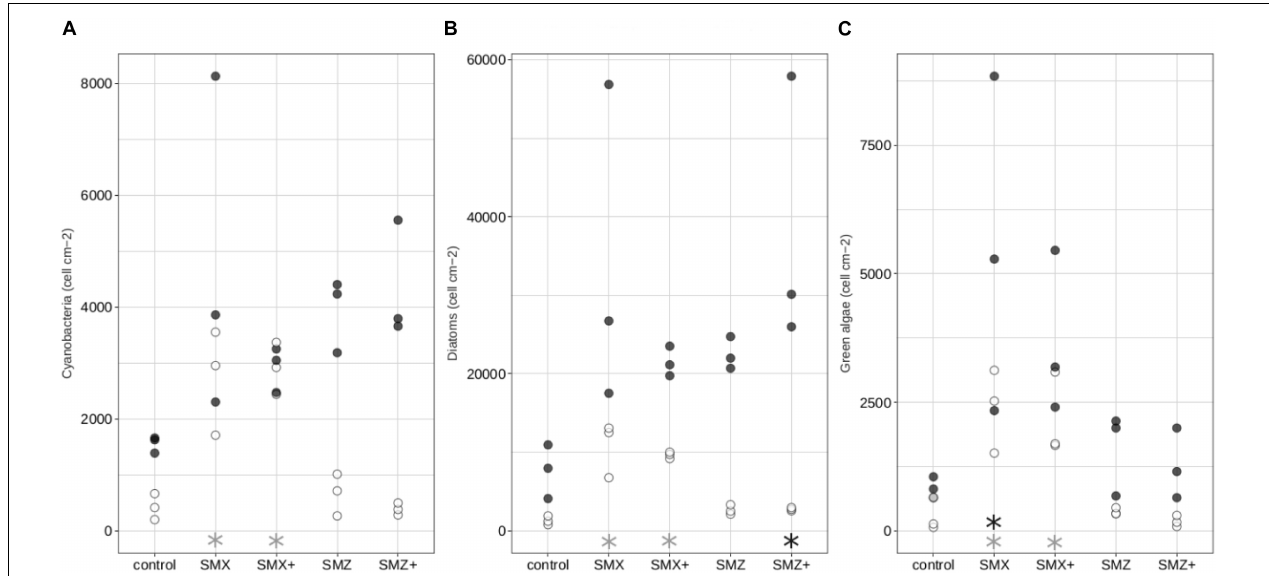
FIGURE 2 | Composition of the autotrophic community: density in cells cm − 2 of cyanobacteria (A) , diatoms (B) , green algae (C) in the control biofilms and biofilms exposed to sulfonamides. White circles correspond to biofilms exposed for 14 days while black circles correspond to biofilms exposed for 28 days. Significant differences ( p < 0.05) between controls and biofilms exposed to antibiotics are indicated by gray stars after 14 days of exposure and by black stars after 28 days of exposure.